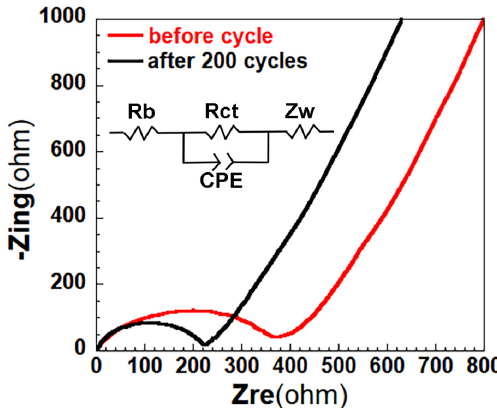
Figure 6. Nyquist plots for the LiFePO 4 |PAN@PSiO|Li battery acquired in the frequency range of 100 KHz to 10 MHz before and after 200 cycles at the current density of 2